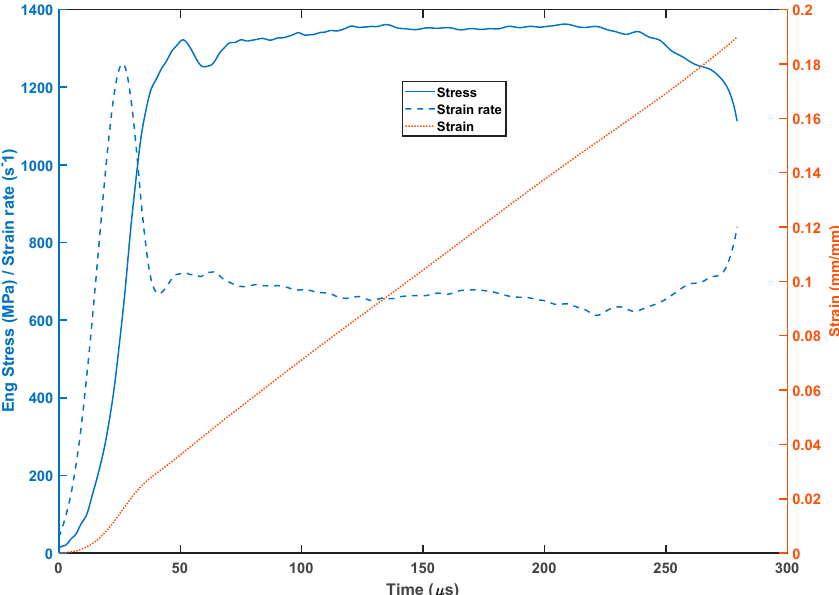
Figure 6. Typical stress, strain rate and the strain against time graph for a 6 mm long SR Direct Metal Laser-Sintered (DMLS) Ti6Al4V specimen.